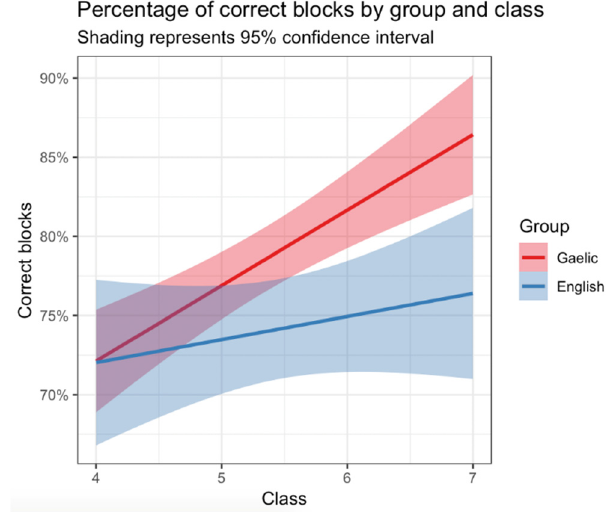
Figure 3. TROG-2 performance by group (Gaelic and English), by class.